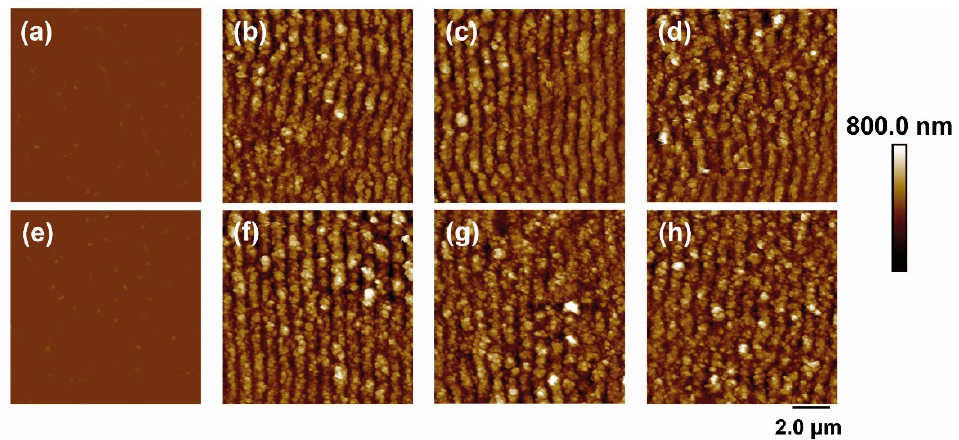
Figure 3. AFM topography images of PET ( top row ) and PET/EG 0.4 wt.% ( bottom row ): ( a , e ) before and after irradiation with a fluence of ( b , f ) 76 mJ/cm 2 , ( c , g ) 87 mJ/cm 2 , and ( d , h ) 94 mJ/cm 2 . Laser irradiation was performed with 50,000 pulses at a wavelength of 795 nm.